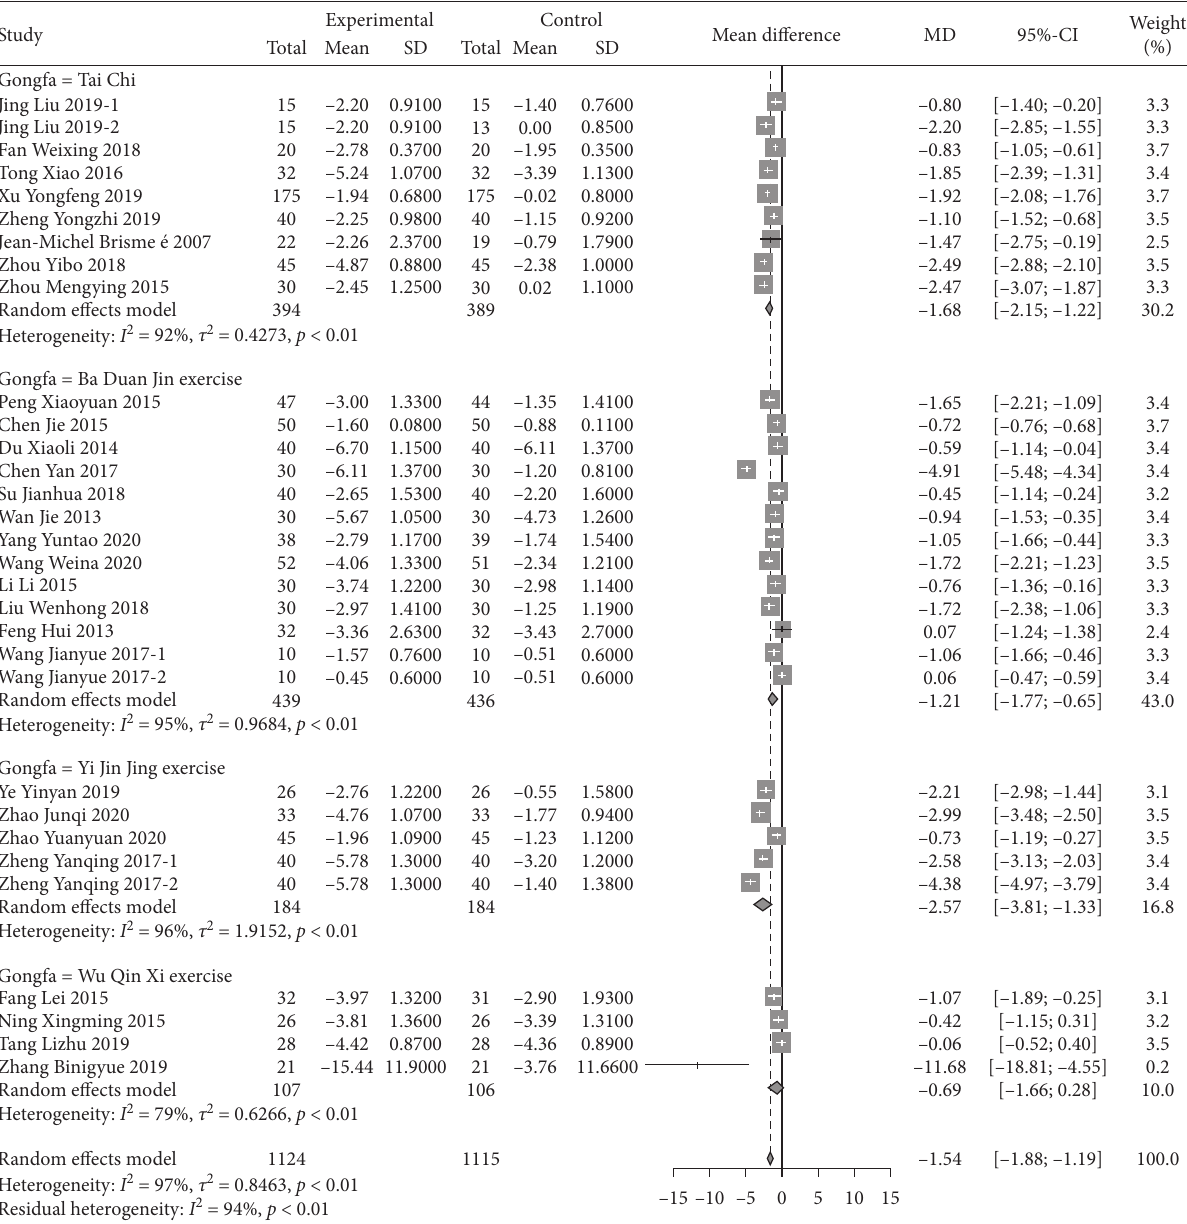
Figure 4: Subgroup analysis of different VAS